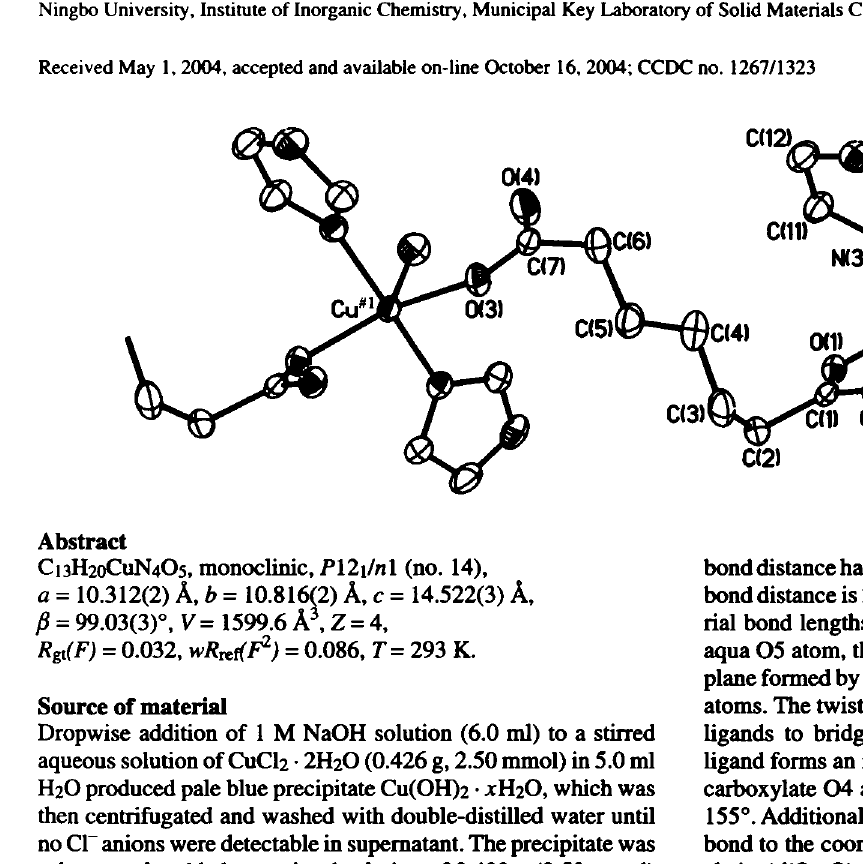
Table 1. Data collection and